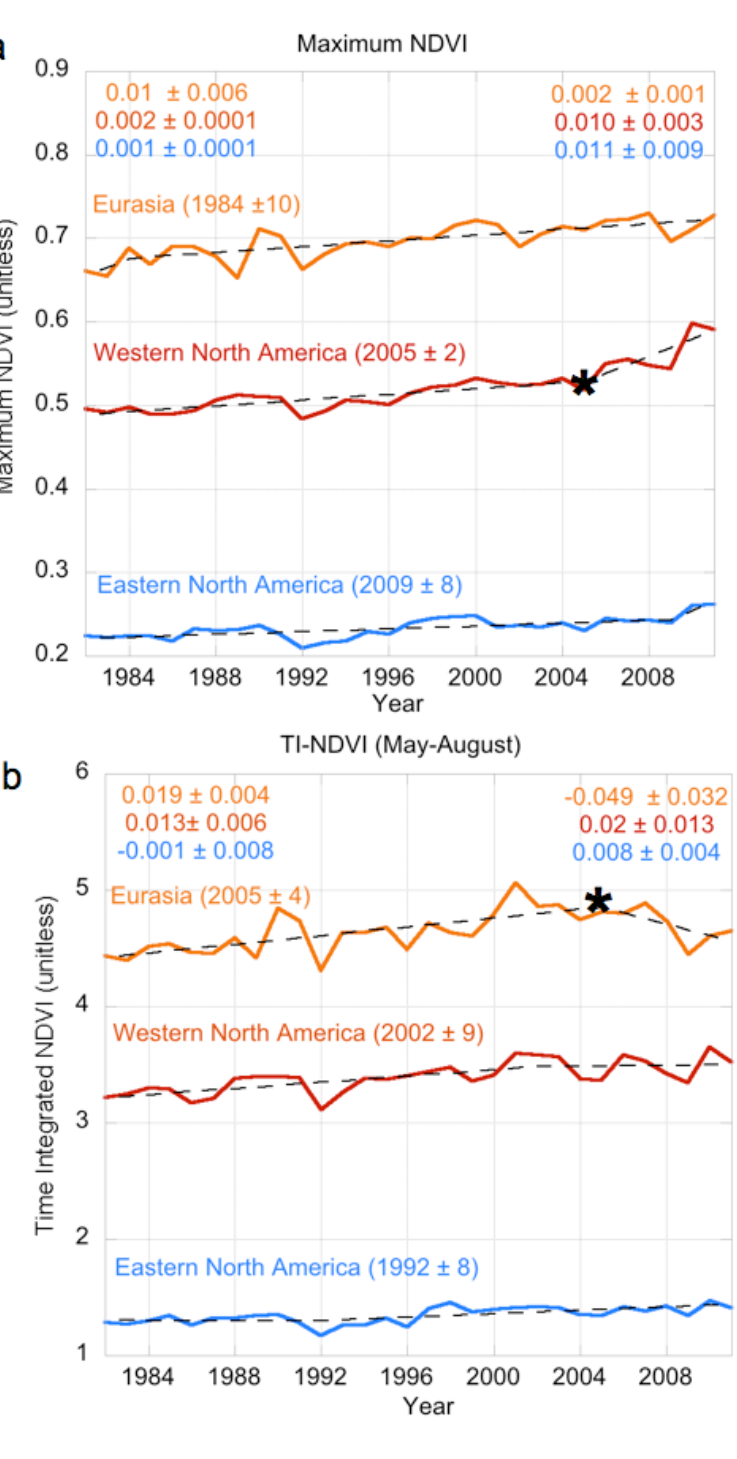
Figure 6. ( a ) Maximum NDVI (unitless) and ( b ) Time Integrated NDVI (unitless) time series for Eurasia (Orange), Western North America (red) and Eastern North America (blue). Trend lines with break points and their associated error are identified for each time series along with the slopes before (top left corner) and after the break points (bottom left corner). Noteworthy break points are identified by a bold star based on the methodology of Mudelsee